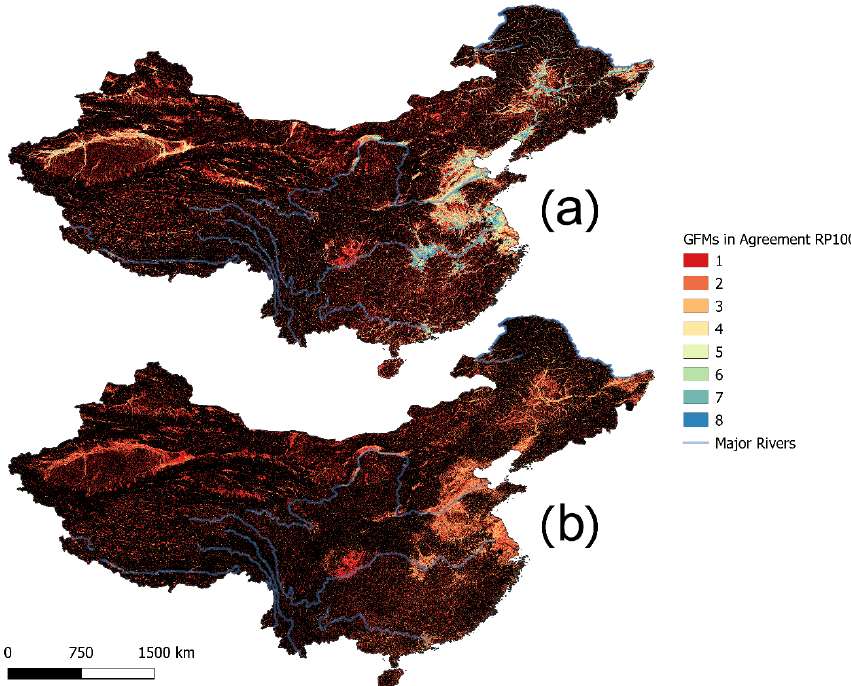
Figure 2. Aggregated flood hazard maps for both flood types, where the numbers and corresponding colours indicate the number of models in agreement on the inundation of a grid cell. (a) Aggregated undefended fluvial-flood hazard maps of seven GFMs for RP100. (b) Aggregated undefended combined (fluvial and pluvial) flood hazard maps of three GFMs for